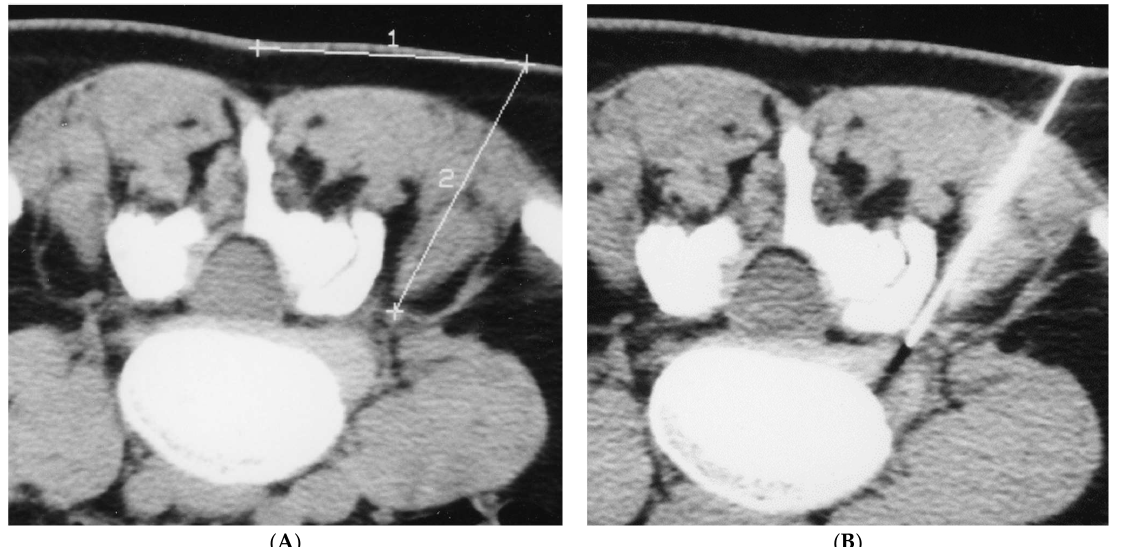
Figure 2. ( A , B ): The puncture site was identified by a CT scan and marked on the patient’s skin. The distance from this point to the foramen was subsequently measured. A 22 G Terumo needle (a 9 cm needle was typically used), was positioned 2–3 mm from the foraminal region, close to the ganglion of the affected nerve root. A CT scan was then repeated to check the correct needle placement.